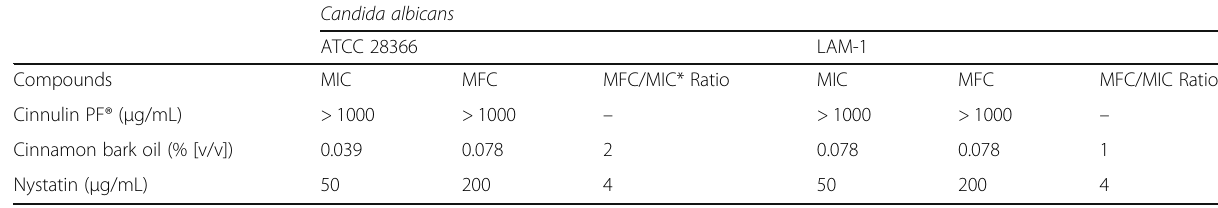
* MFC/MIC Ratio: >4 means fungistatic activity; ≤ 4 means fungicidal